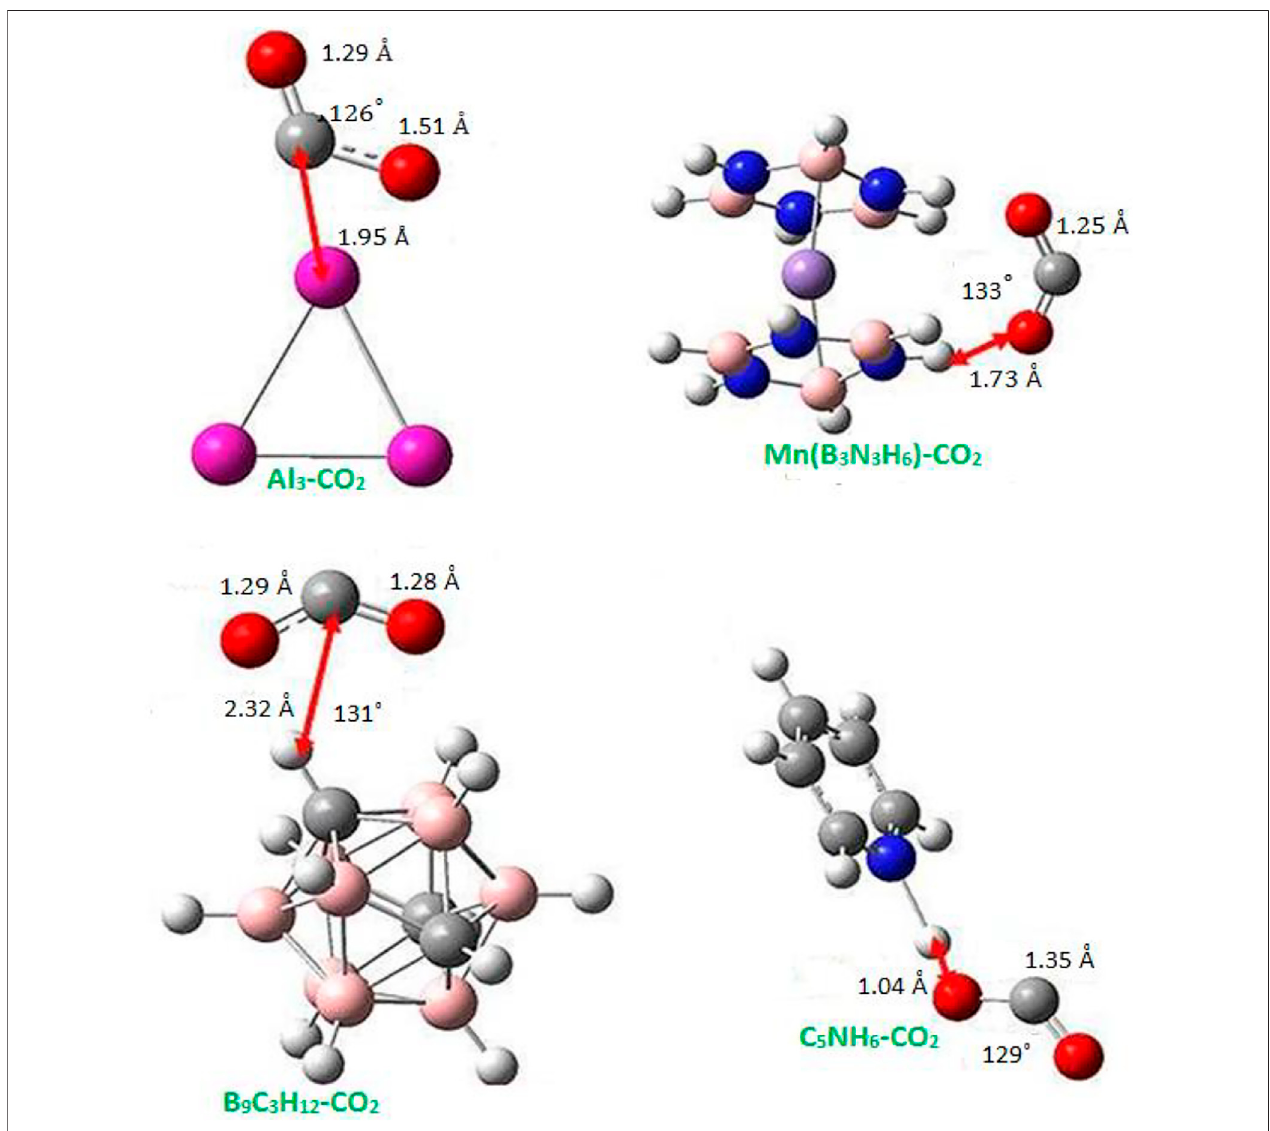
FIGURE 5 | Equilibrium structures of CO 2 complex with special superalkalis from Ref. 19 with the permission of the Royal Society of Chemistry.